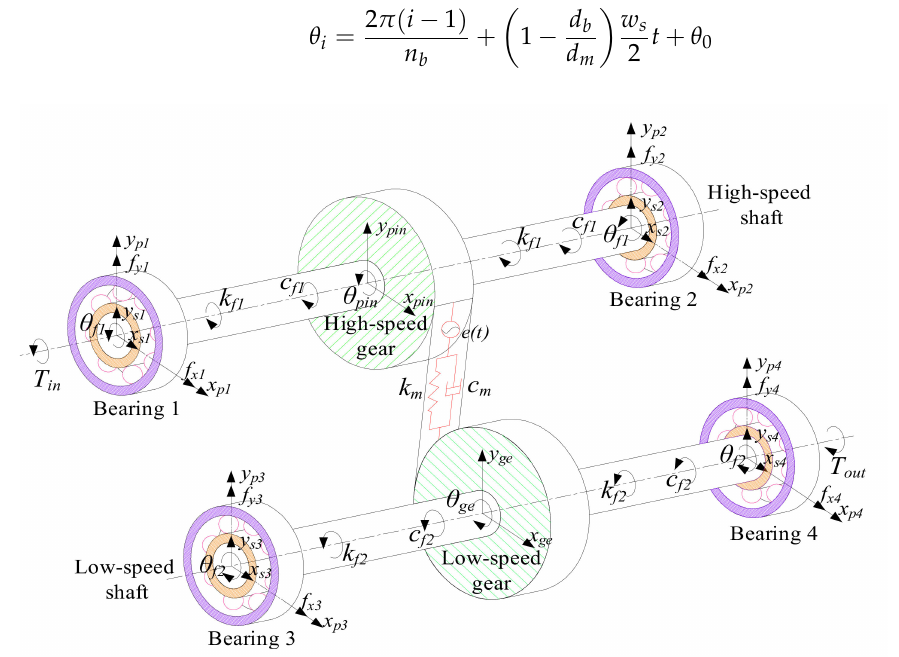
Figure 1. Dynamic model of the bearing-rotor-gear system.